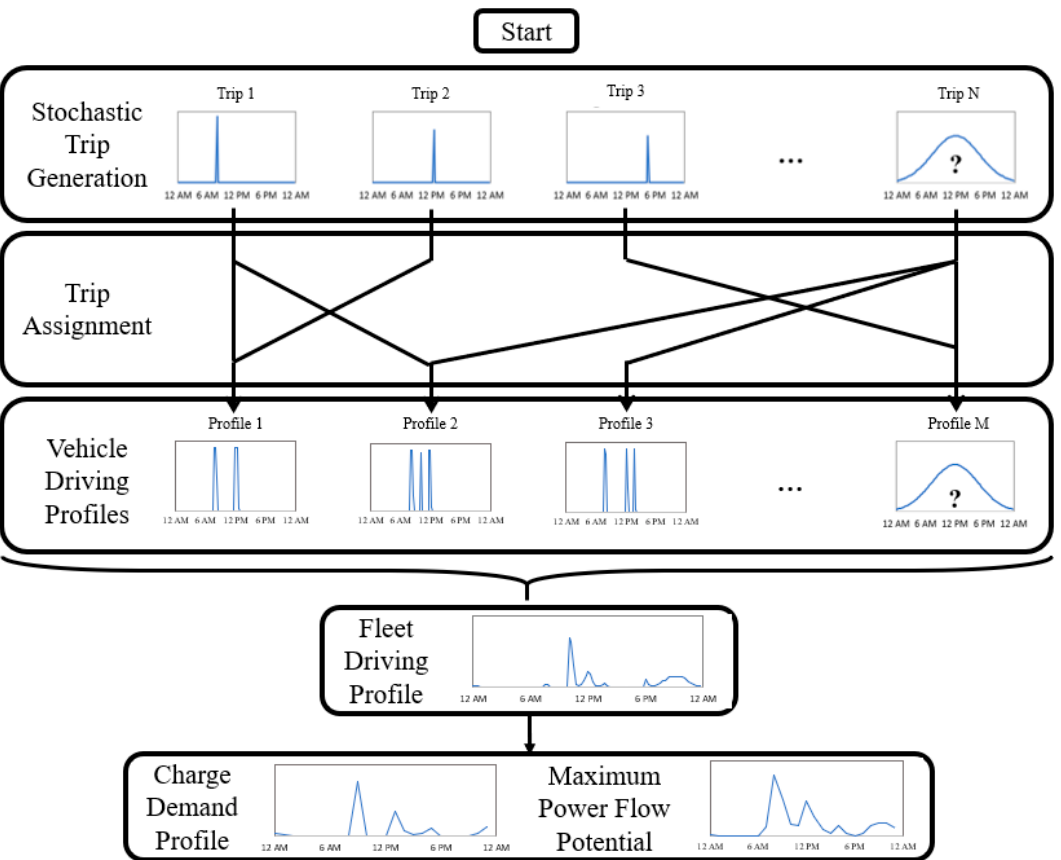
Figure 3 . Flow chart of Monte Carlo simulation for EV fleet charging demand. Figure 3. Flow chart of Monte Carlo simulation for EV fleet charging